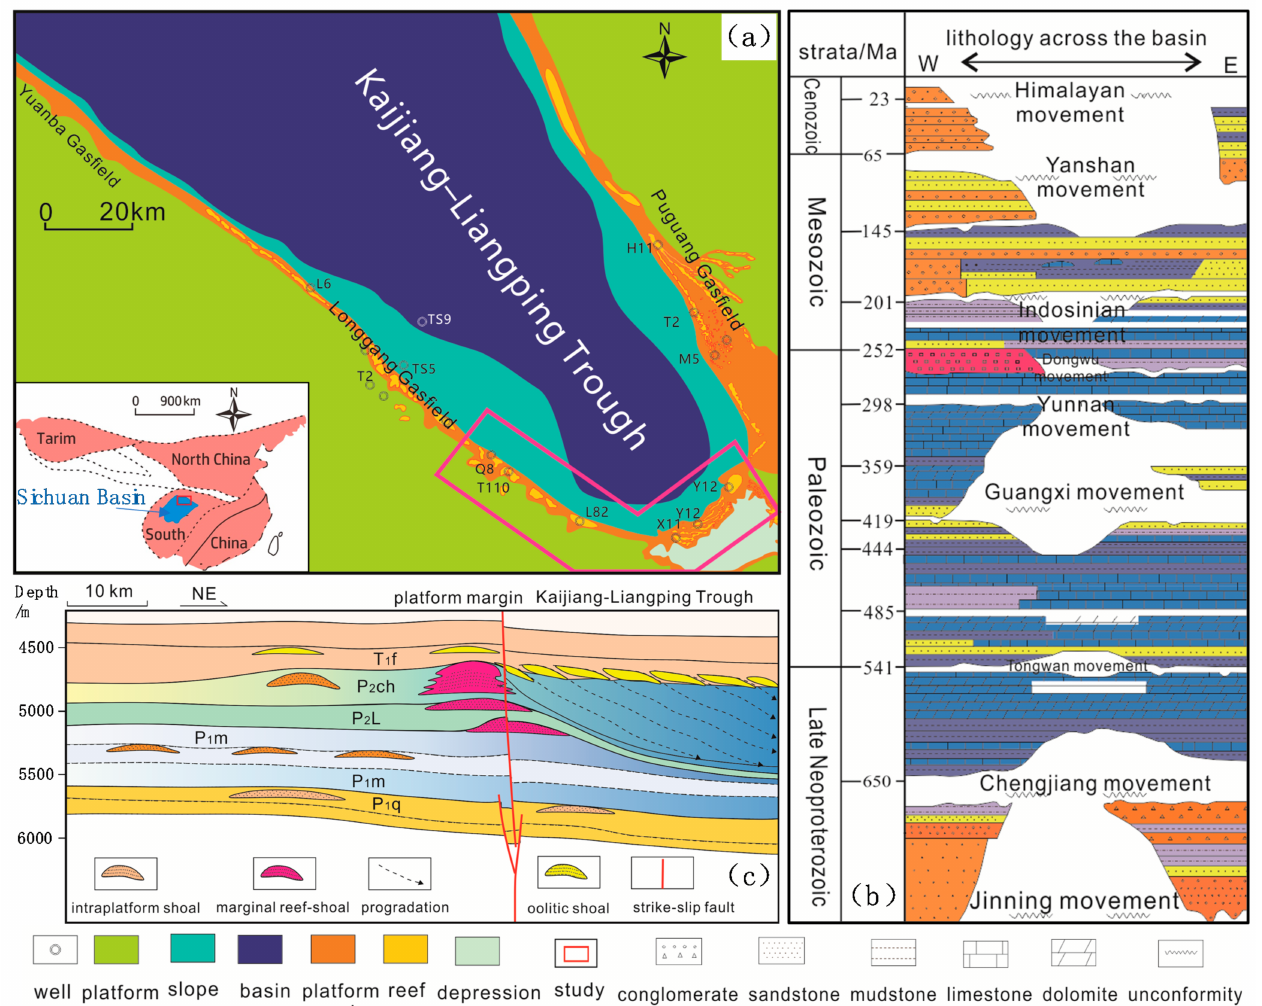
Figure 1. ( a ) Outline of the Kaijiang-Liangping Trough (Inset shows regional location), ( b ) the stratigraphic column, and ( c ) the geological section across the Permian–Triassic platform margin (after Reference